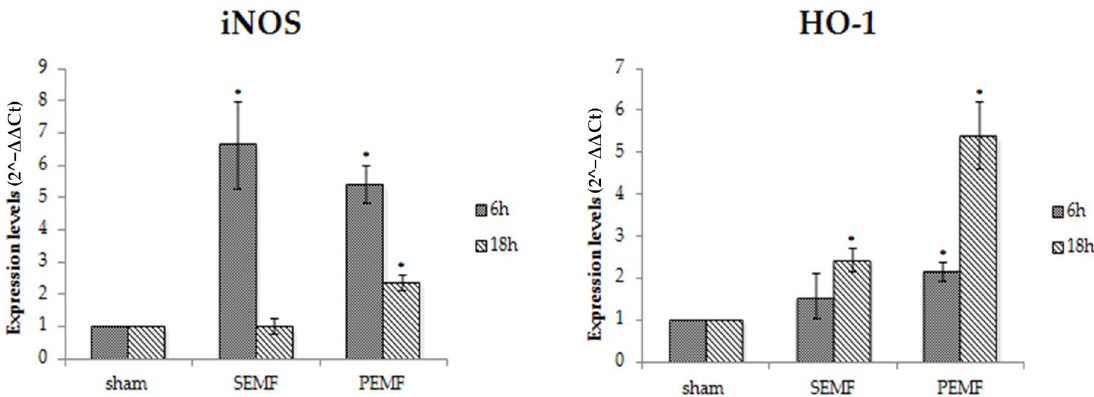
Figure 7. The mRNA expression of inducible nitric oxide synthase (iNOS) and heme oxygenase 1 (HO-1) in hGF exposed to the SEMF and the PEMF compared to sham-exposed cells. iNOS and HO-1 expression levels (2 −ΔΔCt ) are reported as mean ± standard error (SE). * p -Value < 0.05 SEMF or PEMF vs. sham assumed as 1.